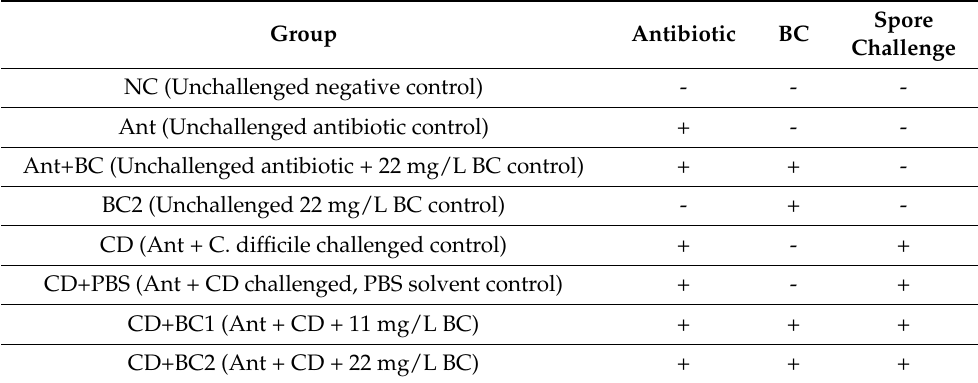
Table 1. Different treatment groups used in the experiment. Abbreviations: Ant (antibiotic); CD ( C. difficile ); BC (baicalin); PBS (phosphate buffered saline). Spore Group Antibiotic BC Challenge NC (Unchallenged negative control) - - - Ant (Unchallenged antibiotic control) + - - + +